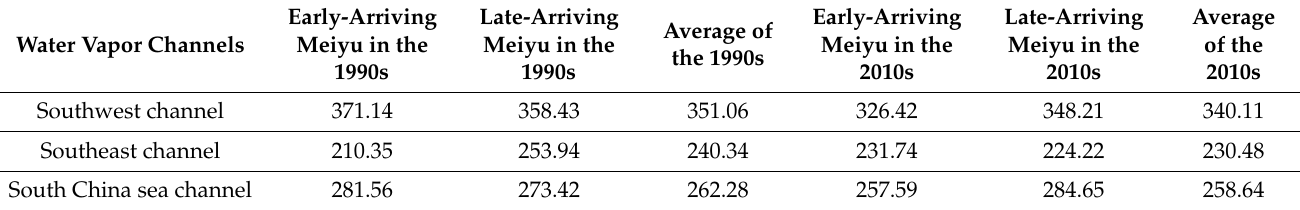
Table 3. Intensity index of water vapor channel in Meiyu period (unit: kg · m − 1 · s − 1 ).